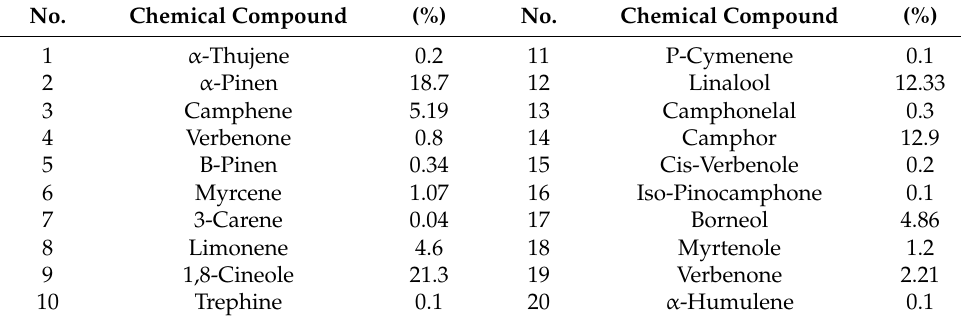
Table 1. Chemical composition of rosemary essential oil